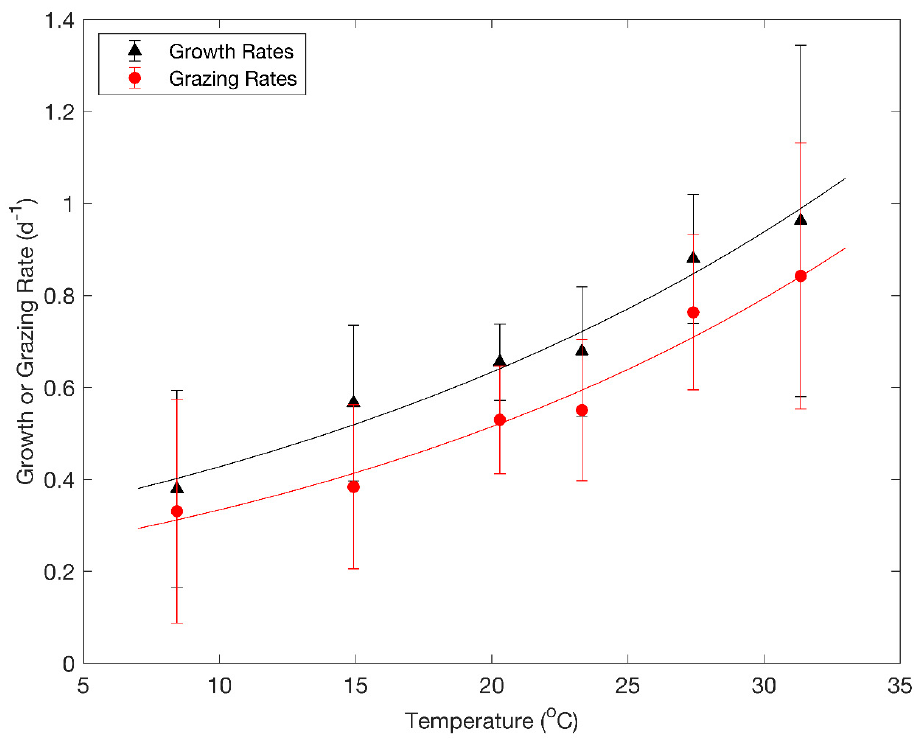
Figure 3. Phytoplankton growth rates (µ, d − 1 ) and zooplankton grazing rates (g, d − 1 ) from this study and from the rates reported by Boyer et al. [15], Lavrentyev et al. [16], Tadonleke and Sime-Ngando [17], Adrian et al. [18], Griniene et al. [19], Staniewski et al. [20], Sterner et al. [21], Tijdens et al. [22], Twiss et al. [23], Weisse et al. [24], Davis et al. [25], and Collos et al. [26]. Data have been binned into six temperature intervals of 5–11, 11–18, 18–22, 22–26, 26–30, and 30–35 ° C. Symbols indicate mean values in each interval, and error bars are standard errors of the means. Solid curves are simple exponential functions of temperature fit to the growth rates (black) and grazing rates (red) and correspond to Q 10 values of 1.48 and 1.54, respectively. In the experiments conducted in University Lake, g equaled G max divided by the initial chl a concentration.